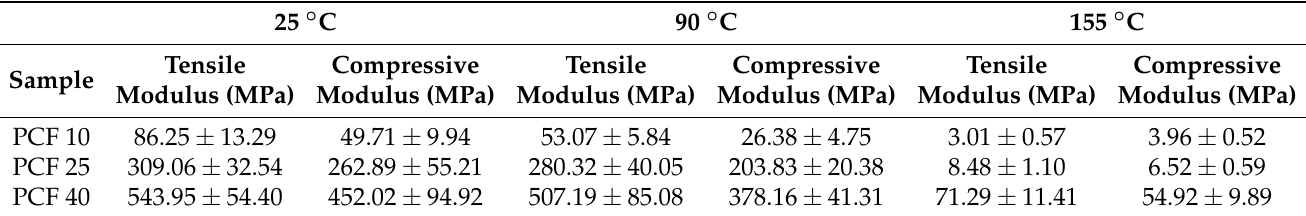
Table 3. Mechanical properties of PUR foams measured in experimental